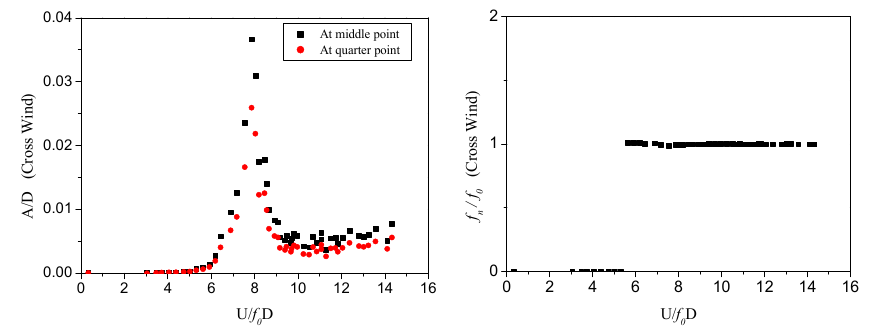
Figure 7. Crosswind amplitude and frequency response of the 3D prototype prism.